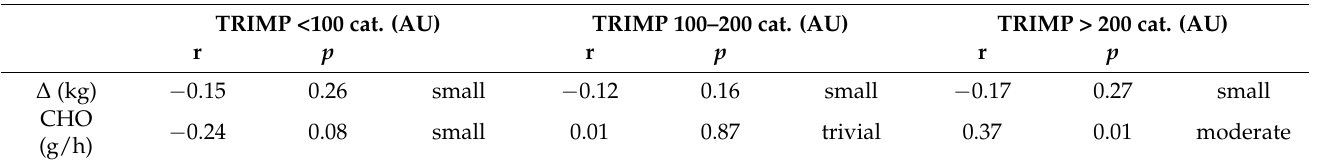
Table 2. Results of the correlation analysis between TRIMP within the three different categories, pre- and post-training ∆ (kg) and CHO consumption